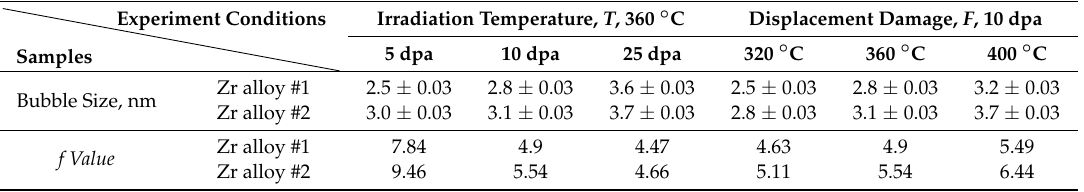
Table 1. The sizes of gas bubbles and coefficient f values.